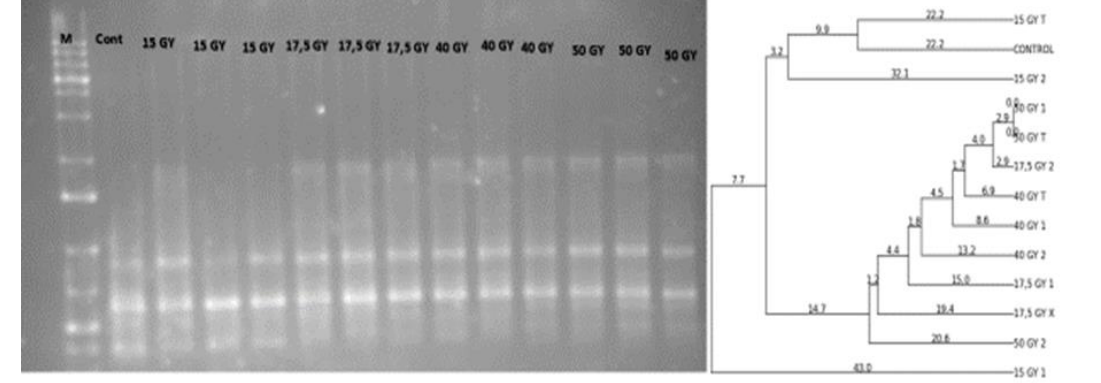
Figure 8. The agarose gel picture of ISSR (UBC-856) markers PCR with 12 Ocimum basilicum